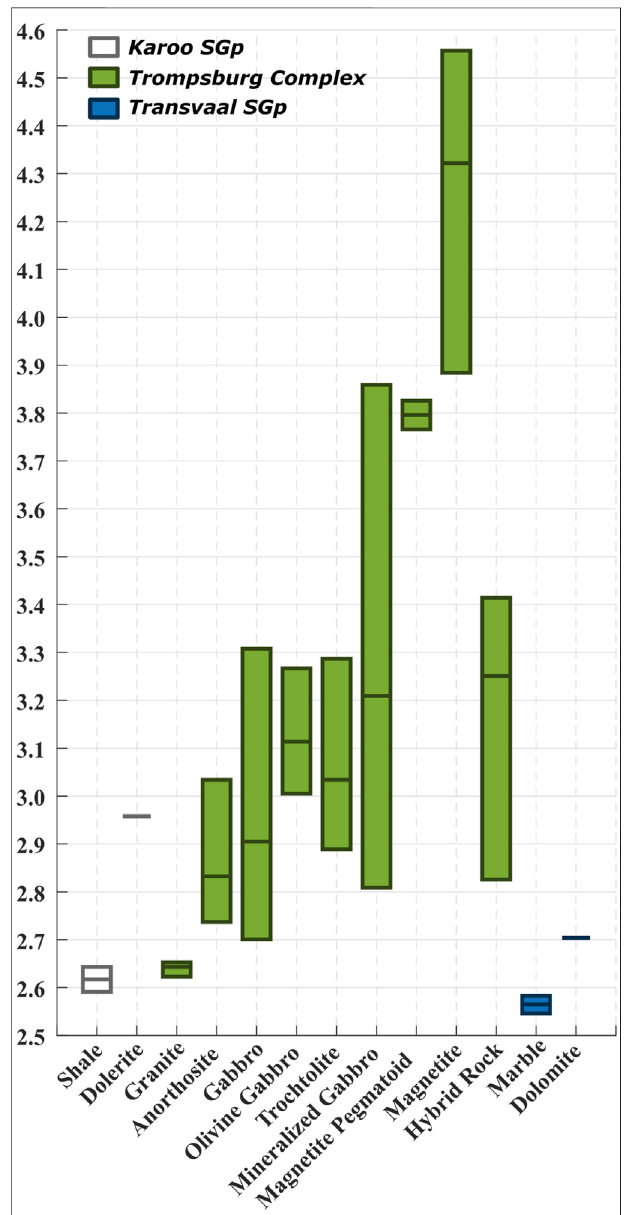
Frontiers in Earth Science |